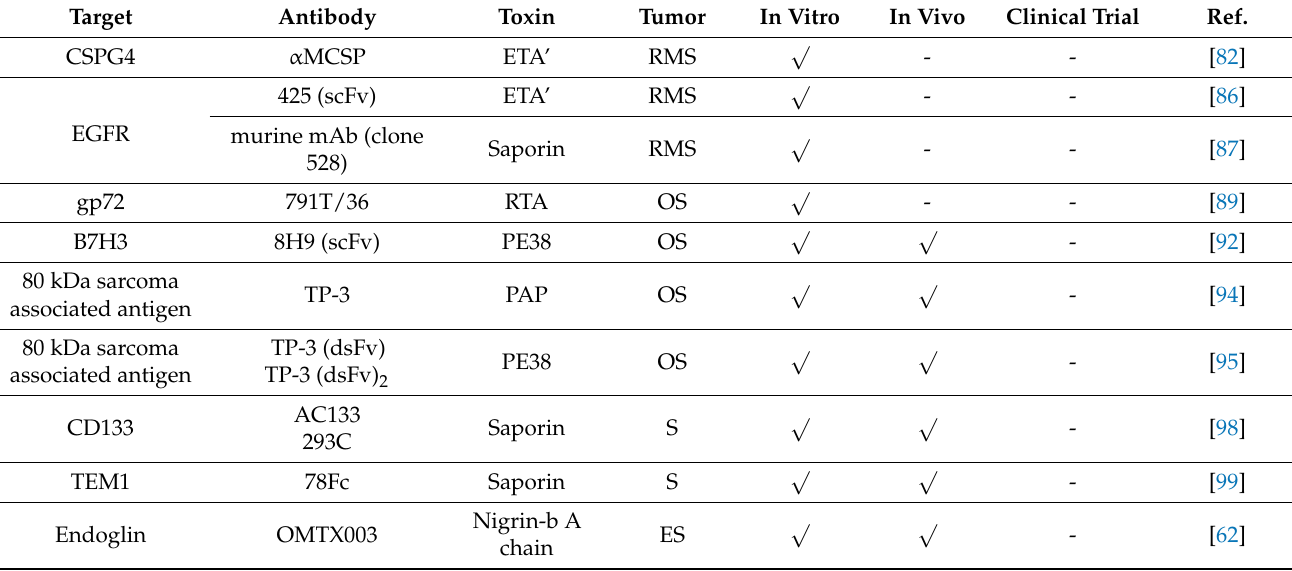
Table 2. Immunotoxins tested for sarcoma